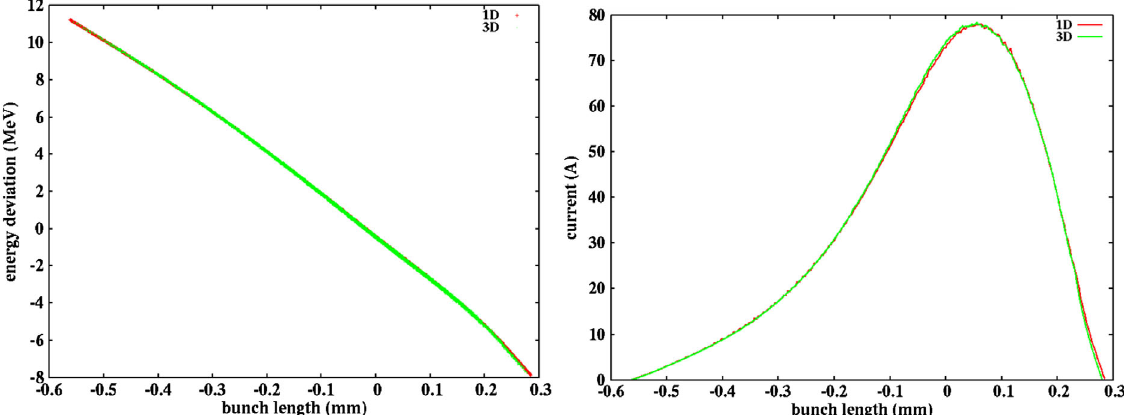
FIG. 3. Longitudinal phase space distribution (left) and current profile (right) after BC1 of the linac from the 1D model (red) and from the 3D model